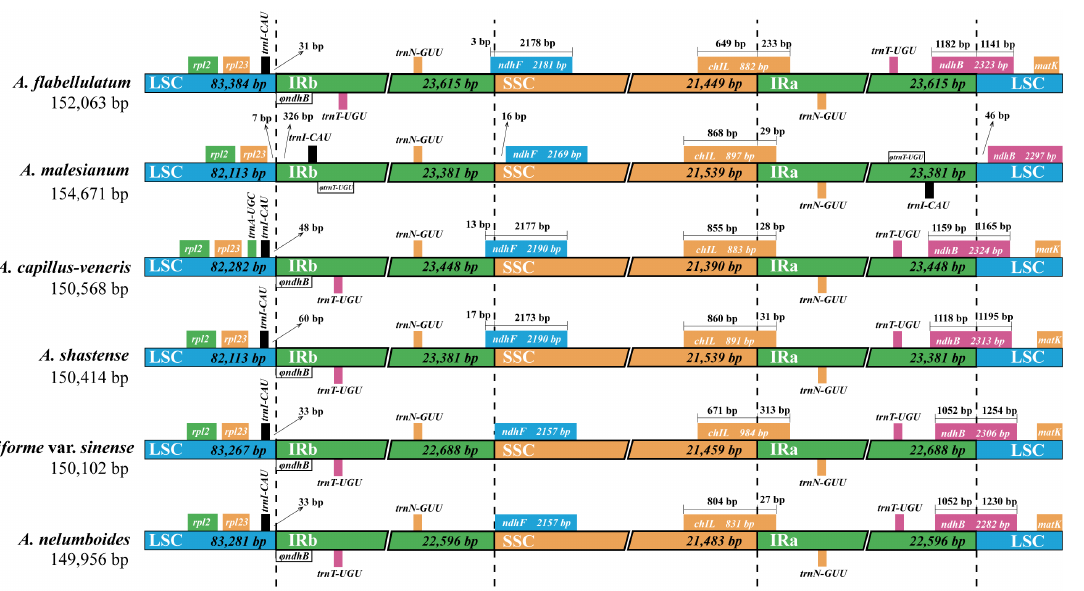
(Figure 2). For instance, ndhB genes span the IRa/LSC boundary across all species except for A. malesianum . All five species IRb contain trnT-UGU except for A. malesianum . The boundary, with a distance to the boundary between 31–60 bp in the other five species. More- over, although chlL genes cross the SSC/IRa boundary in the six cp genomes, the length located in IRa is significantly longer in A. reniforme var. sinense (313 bp) and A. flabellulatum